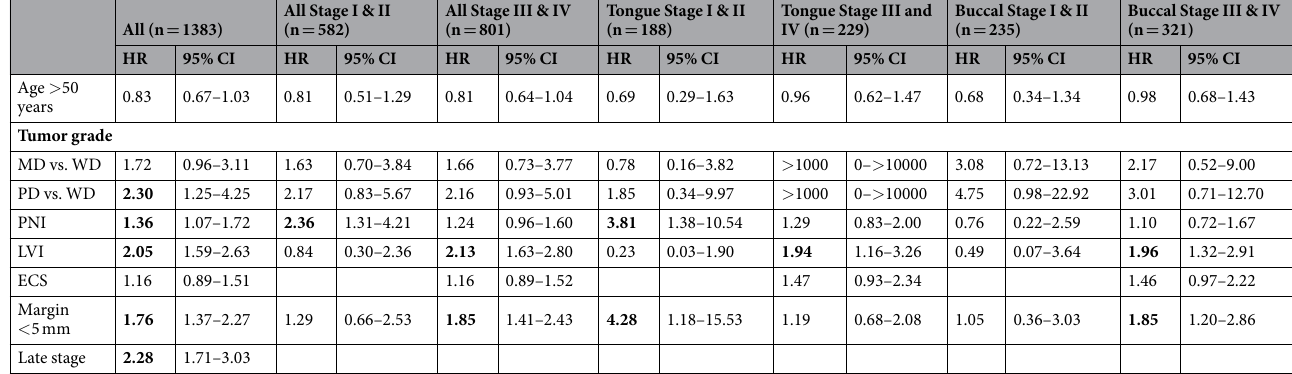
Table 4. Multivariate analysis of the impact of clinic-pathological features on the survival of oral squamous cell carcinoma patients based on pathological stage and subsites (the tongue and the buccal mucosa only).